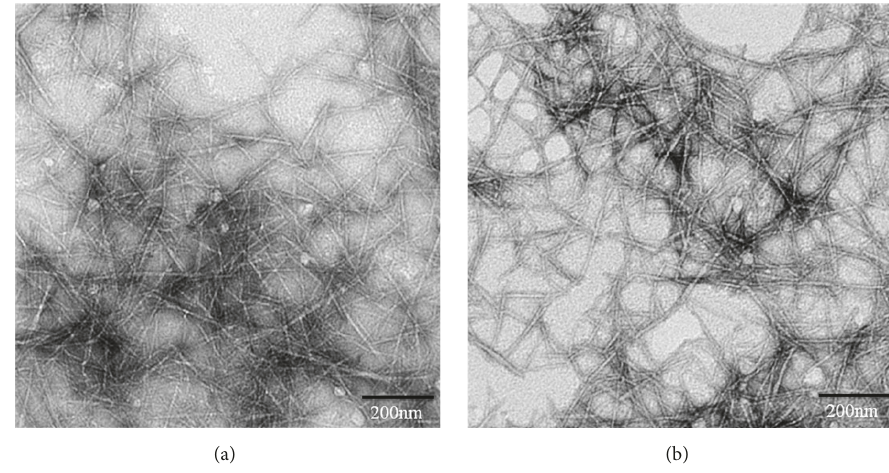
Figure 10: TEM images of water-redispersed samples: (a) DS = 0.135 and (b) DS =